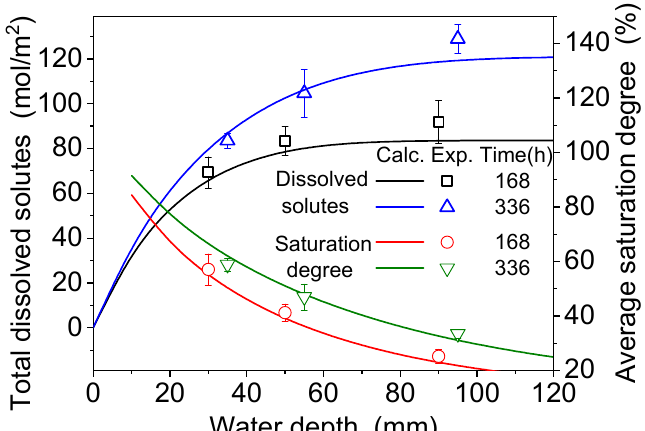
Figure 7. Saturation degrees and dissolved solute amounts of resulting solution at different times and Figure 6. Local concentrations of solute at different times and locations in the dissolution and immersion depths (in the dissolution and diffusion processes of bloedite). diffusion processes of bloedite; the experimental data after 2000 h are the test results in the salt pond of Yuncheng Salt Lake, China.